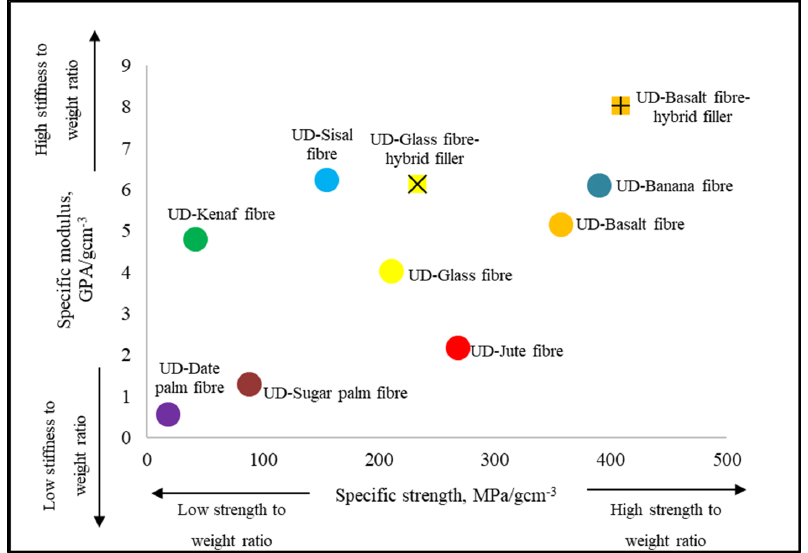
Figure 11. Summary of the specific modulus versus specific strength of different types of natural FRP composites when compared to Glass FRP composites [41–45].